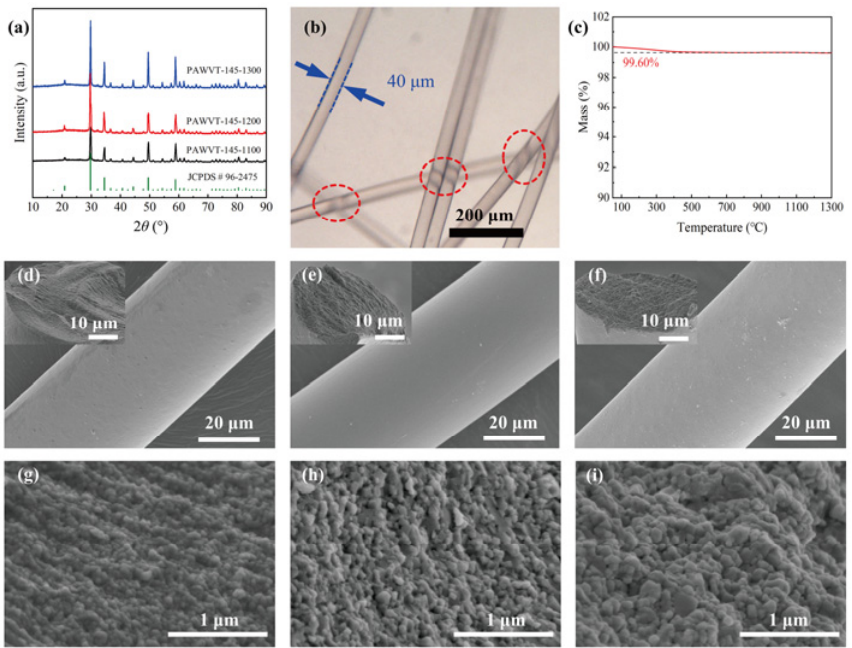
Fig. 8 (a) XRD patterns of Lu 2 O 3 continuous fibers. (b) Optical microscopy photo and (c) TG curve of PAWVT-145–1100. SEM images of Lu 2 O 3 continuous fibers: (d, g) PAWVT-145–1100, (e, h) PAWVT-145–1200, and (f, i) PAWVT-145–1300.